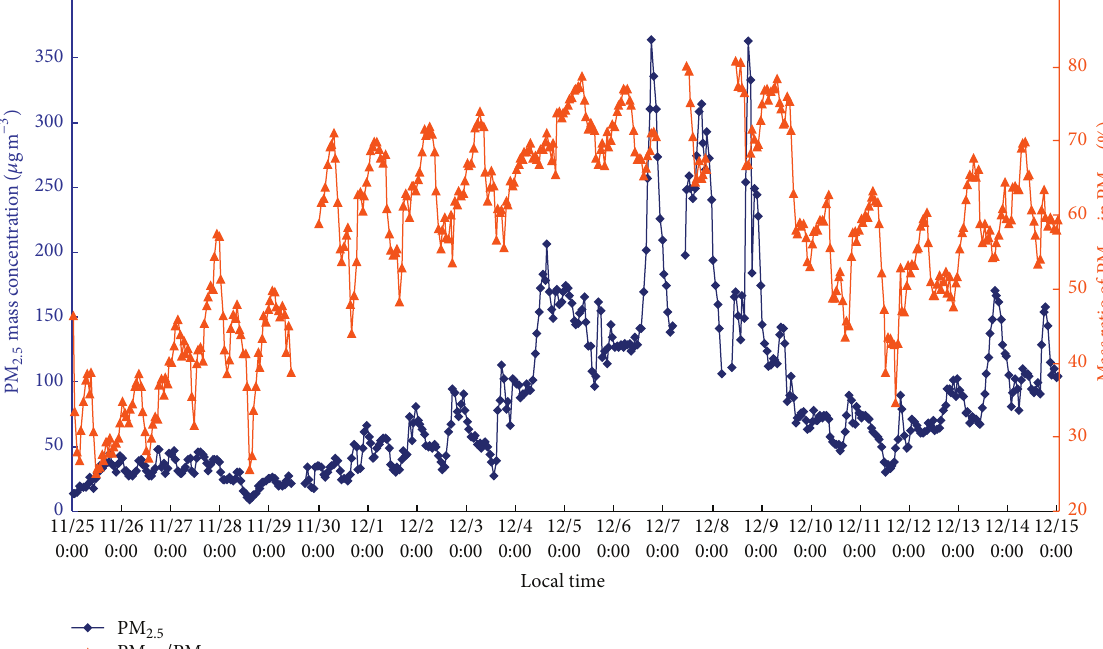
Figure 3: Hourly mean mass concentration of PM 2.5 and mass proportion of PM 2.5 in PM 10 at Lin’an regional background station.